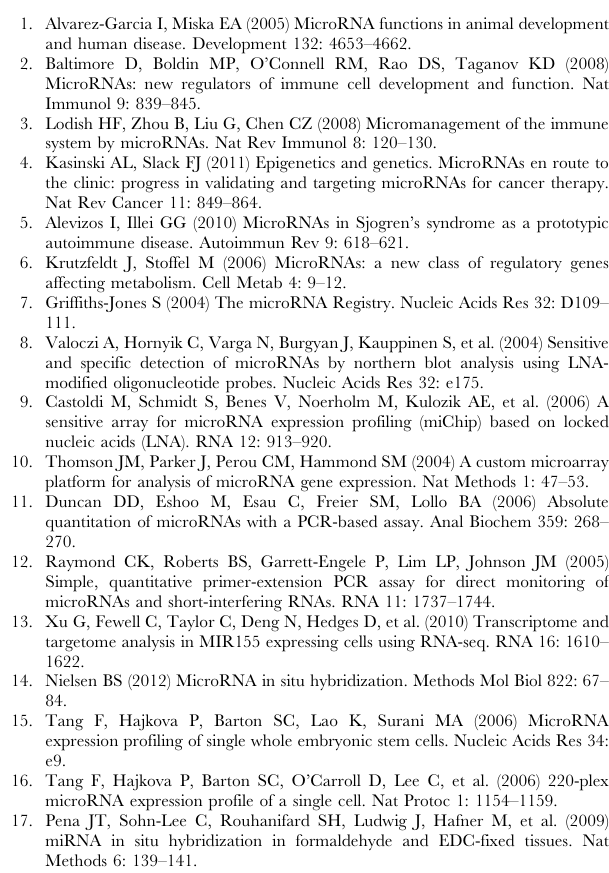
Figure S2 Schematic of EDC fixation mechanism. The 5 9 phosphate of miRNA are activated by EDC to form an